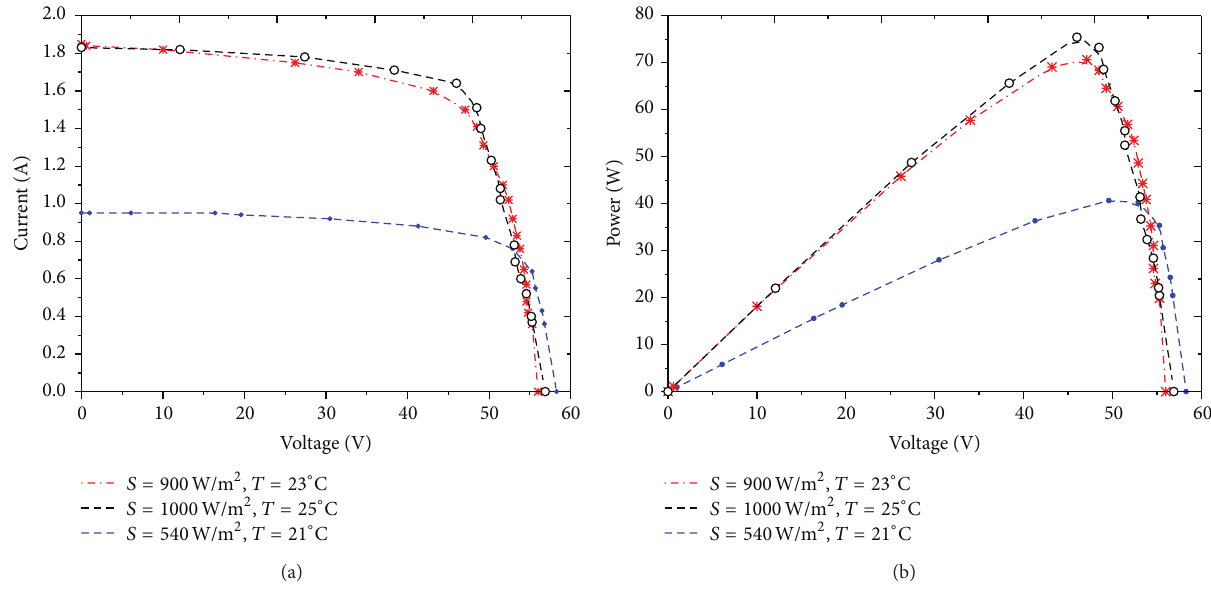
Figure 3: (a) 𝐼 - 𝑉 characteristic curve under different conditions. (b) 𝑃 - 𝑉 characteristic curve under different conditions.